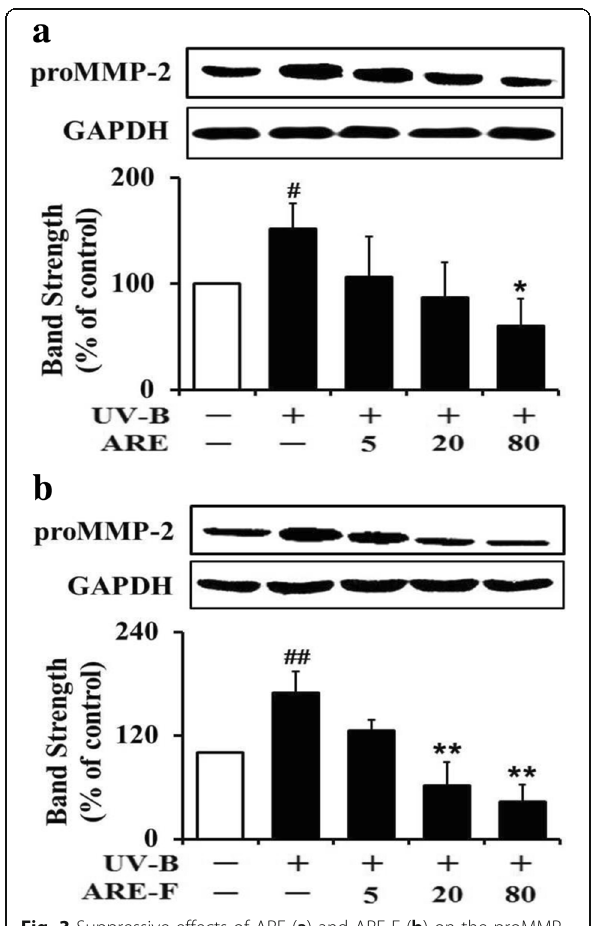
Fig. 3 Suppressive effects of ARE ( a ) and ARE-F ( b ) on the proMMP- 2 elevation in HaCaT keratinocytes under UV-B irradiation. HaCaT cells were subjected to the varying concentrations (0, 5, 20 and 80 μ g/mL) of ARE ( a ) and ARE-F ( b ) for 1 h before the irradiation. The proMMP-2 proteins in cellular lysates, detected using western blotting analysis, were expressed as a percentage (%) of the corresponding non-irradiated control. In the lower panels of both a and b , the band strength was determined with densitometry using the ImageJ software which can be downloaded from the NIH website. # P <0.05; ## P <0.01 versus the non-irradiated control. * P <0.05; ** P <0.01 versus the non-treated control (UV-B irradiation